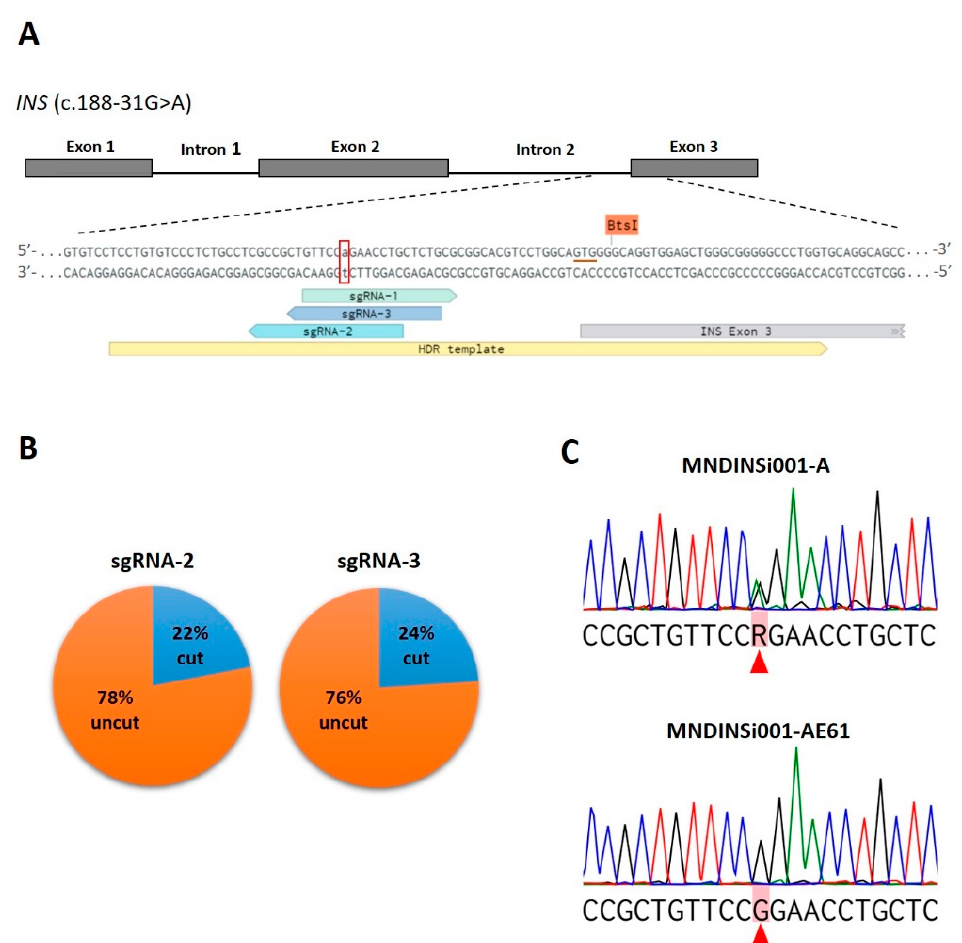
Figure 1. CRISPR/Cas9-mediated correction of a heterozygous mutation c.188-31G>A in the INS gene in patient-specific iPSCs. ( A ) Schematic representation of the mutated region of INS with designed allele-specific sgRNAs (sgRNA-1, -2, -3) and ssODN used as HDR template. The mutated nucleotide (adenosine) is indicated by lowercase letter and labeled with a red open box. The underlined triplet GTG (in red color) indicates a position of synonymous mutation (GTC) in the ssODN for disrupting BtsI restriction site. ( B ) Pie charts show the cutting efficiency of sgRNAs observed in CRISPR/Cas9-edited patient-specific iPSCs. ( C ) Sequencing chromatograms of patient-specific MNDINSi001-A cells with the heterozygous mutated alleles of INS and successfully edited clone MNDINSi001-AE61 with wild type alleles. Red triangles indicate heterozygous mutated and the corresponding corrected nucleotides. R = G or A according to the IUPAC nucleotide code.